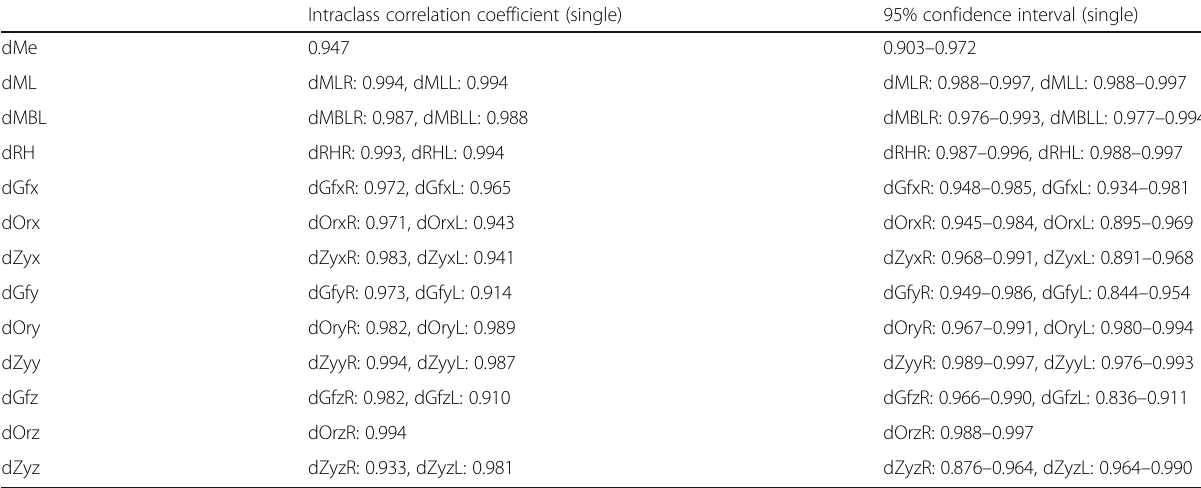
Table 5 Intraclass correlation coefficient of craniofacial distance measurements ( N =